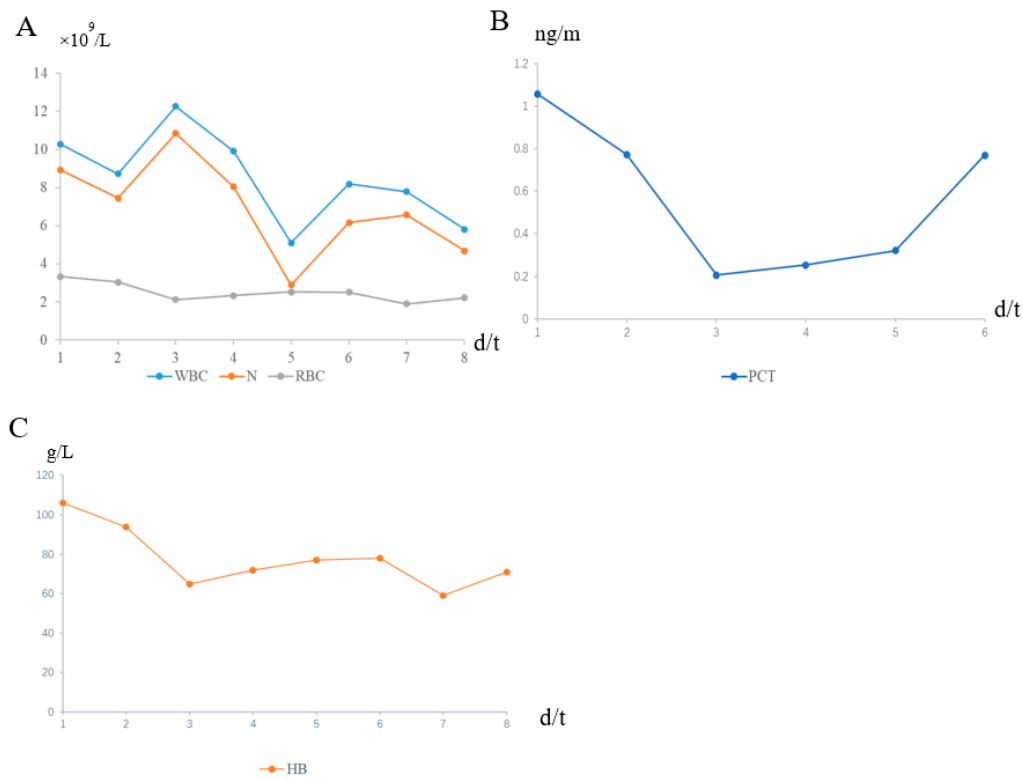
Figure 3. The patient developed intermittent hematemesis and the infection worsened. The patient’s blood routine examination showed that HB was lowered. After each blood transfusion treatment, the patient’s HB increased again ( C ). After the patient’s hematemesis was controlled, the re-examination under the endoscopy was performed again, and no bleeding points were found. Then, a series of inflammatory indicators were checked on the patient. The trend of changes in white blood cells (WBC) and neutrophils (N) after admission is basically consistent ( A ). After the patient was admitted to the hospital, the procalcitonin (PCT) increased significantly. After active treatment, the PCT improved significantly, but due to the continuous infection, the patient’s PCT testing increased again ( B ). The degree of changes in the red blood cell (RBC) to the haemoglobin (HB) in ( A ), after the patient is admitted, is mutually consistent ( C ). According to patients’ blood routine test results, acute infection was considered, and anti-infection was actively given for treatment. After anti-infective treatment, blood routine, PCT and other detection indexes were significantly decreased. During the subsequent course, the patient was infected repeatedly. WBC, reference range (3.5 − 9.5) × 10 9 /L; N, reference range (1.8 − 6.3) × 10 9 /L; RBC, reference range (4.3 − 5.8) × 10 12 /L; PCT: reference range <0.05 ng/mL; HB, reference range (130–175) g/L).